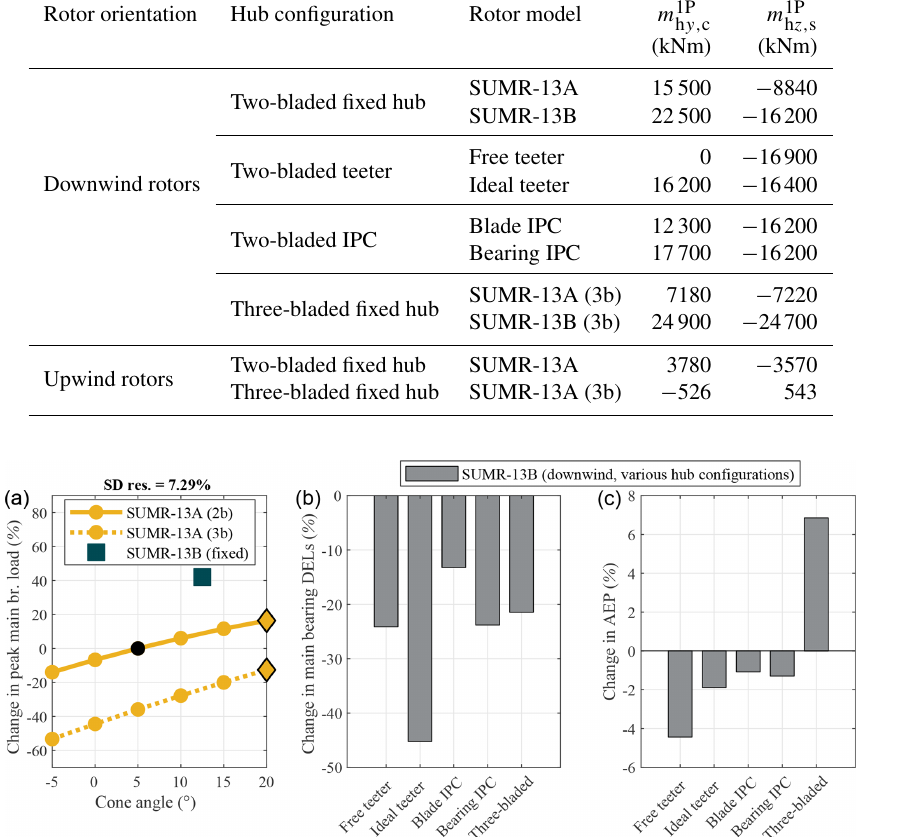
Figure 13. Change in peak main-bearing loads (a) for the SUMR-13A cone angle study (two- and three-bladed rotors) and the SUMR-13B fixed-hub configuration, change in main-bearing DELs (b) about the y s axis (DELs about the z s axis are within 5% of the y s -axis DELs) and change in AEP (c) for various hub configurations of the SUMR-13B, compared with the fixed-hub, two-bladed SUMR-13B final design described in Sect. 8.2. The DEL and AEP results from different hub configurations (b, c) are design loads computed directly from DLC